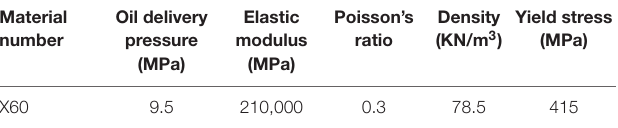
TABLE 3 | X60 pipe material